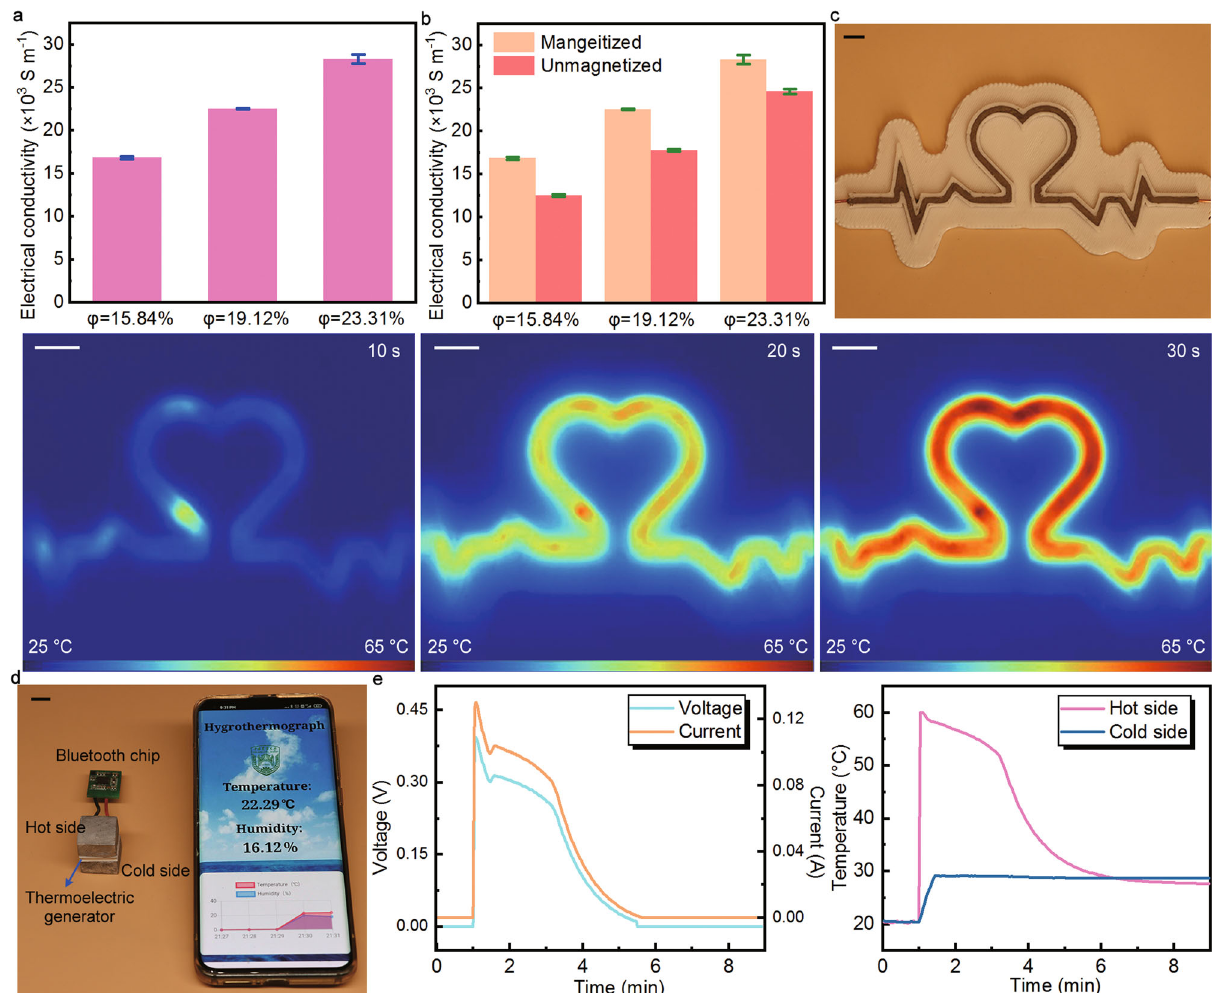
Fig. 5 Energy conversion and storage applications of magnetically tightened form-stable phase change materials (MTPCMs). a Electrical conductivities of MTPCMs with different volume ratios. b Electrical conductivities of MTPCM and unmagnetized composites. c Photo and thermal infrared images of MTPCMs during the electricity-to-heat conversion process. Scale bars: 5 mm. d Photo of the heat-to-electricity conversion and storage system. Scale bar: 10 mm. e Output voltage and current, and temperature evolution curves of the heat-to-electricity conversion and storage